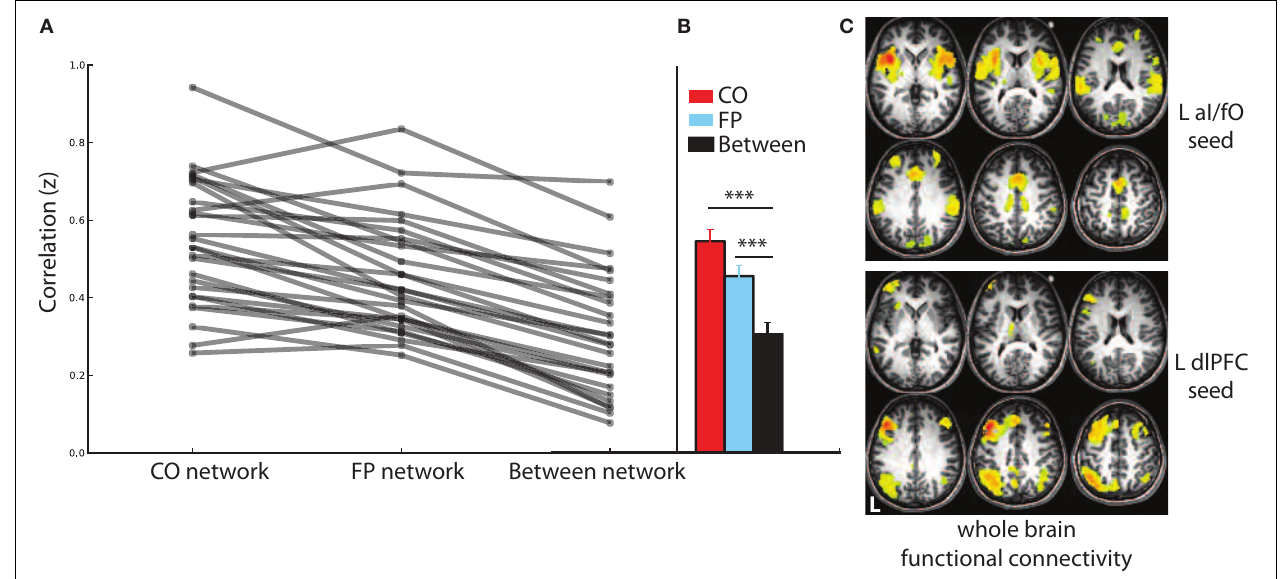
FIGURE 2 | Connectivity in the CO and FP networks before TBS. (A) Connectivity within the CO and FP networks and across the two networks are shown for each individual (gray lines). Across all individuals, within network connectivity was higher than between network connectivity. (B) Statistics across the group of subjects confirm these findings, with connectivity within the CO network (red) and within the FP network (blue) significantly higher than connectivity